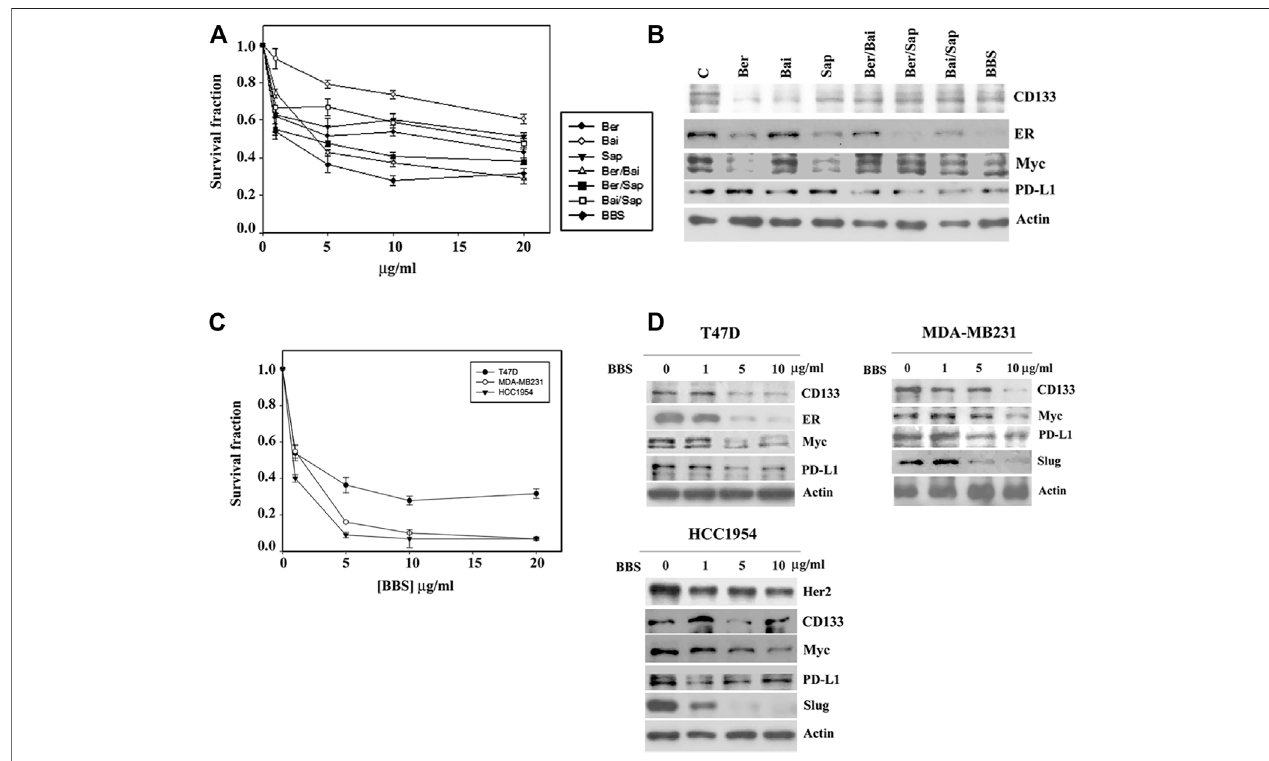
FIGURE6| ThebiologicaleffectoftheBBSformula. (A) T47Dcellsweretreatedwithvariousdosesofberberine(Ber),baicalin(Bai)andsaponin(Sap)orallpossible combinations for 4 days. The level of surviving cells was determined by MTT assay. Formula BBS is a combination treatment with berberine (Ber), baicalin (Bai), and saponin (Sap). (B) T47D cells were treated with 5 μ g/ml of each single or all possible combinations of the indicated agents for 24 h. Western blotting analysis was performedtocharacterizethechangeintheproteinexpressionpro fi le.Threebreastcancercelllines,T47D,MDA-MB231andHCC1954,weretreatedwithvarious dosesoftheBBSformula.TheeffectoftheBBSformulaoncellgrowthwasdeterminedbyMTTassay (C) ,andproteinexpressionwascharacterizedbyWesternblotting analysis (D) . The survival fraction showed the fold change relative to the levels observed in the untreated control. The data are presented as the mean ± SD.